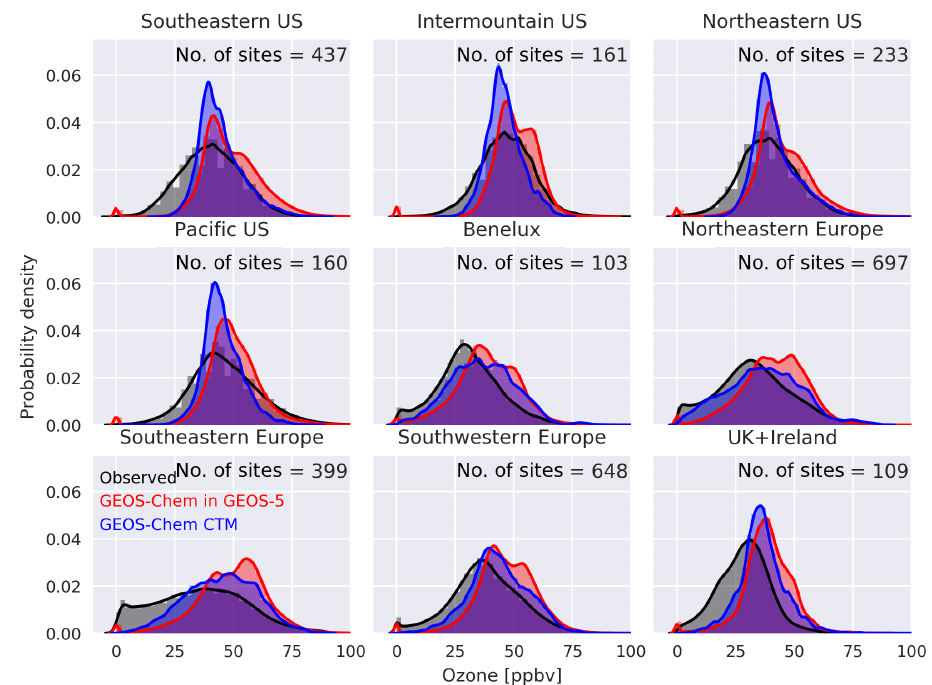
Figure A3. Probability distribution of afternoon (12:00–16:00LT) ozone concentrations (ppbv) for 2013–2014 at surface sites in the US and Europe.